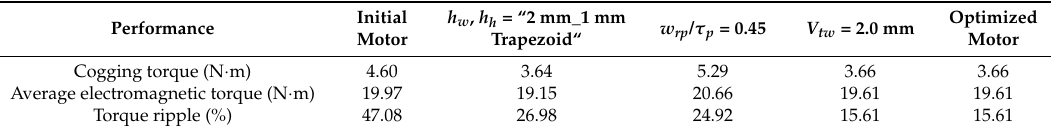
Table 3. Torque performances in the initial motor and the optimized motor.